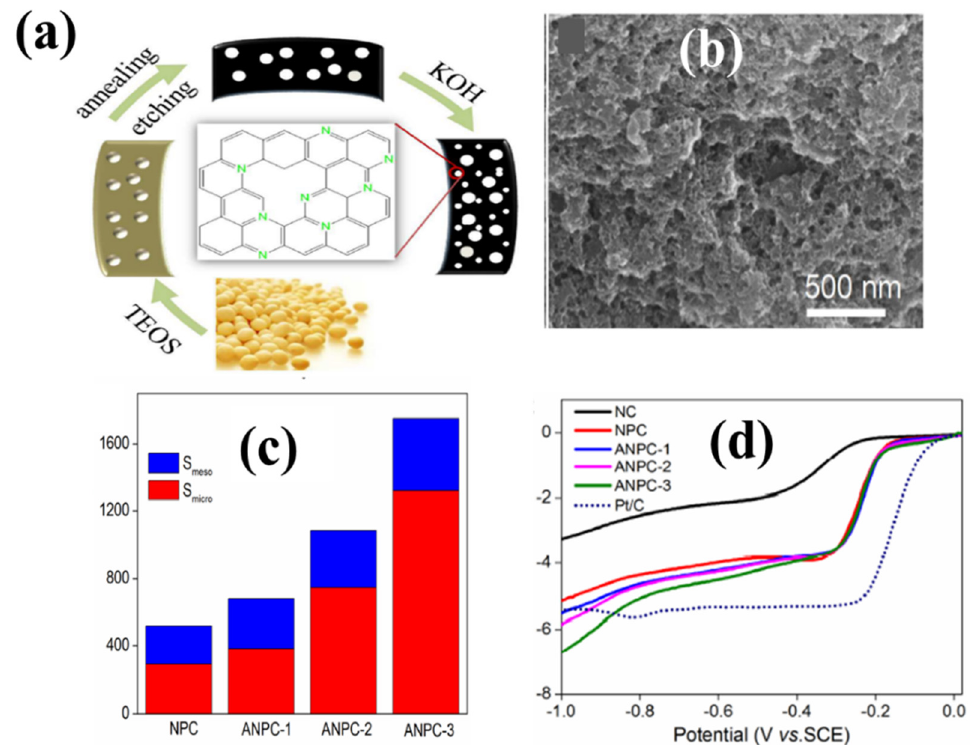
Figure 6. ( a ) Synthesis procedure diagram, ( b ) SEM image of ANPC–3, ( c ) the surface area values in the range of mesopores and micropores, ( d ) LSV curves of samples at 1600 rpm, adapted from [56].